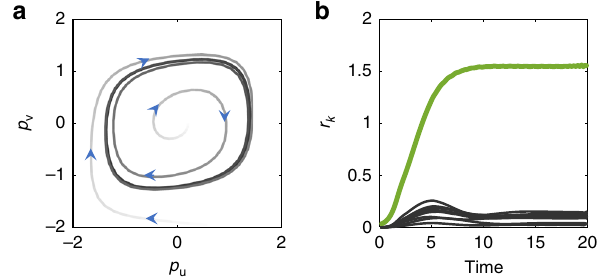
Fig. 4 Dynamics of memory retrieval with fi xed connectivity. a Overlaps of network activity x with the two directions spanning one embedded memory : ¼ 1 ffiffiffi plane, p u > x and p v : ¼ 1 ffiffiffi v > x form a stable limit cycle. Shown are u N p N p two trajectories, one initiated inside and the other outside the stable orbit, with arrowheads showing the direction of temporal evolution ( N = 4096, ρ = 4). b Radial coordinates of overlaps with each of multiple ( M = 10, q ffiffiffiffiffiffiffiffiffiffiffiffiffiffiffiffiffiffiffiffiffi N = 4096) embedded memory planes, r : ¼ p 2 . Initiating the þ p 2 k u k ð Þ v k ð Þ network near one plane, u (1) , v (1) , results in convergence to the